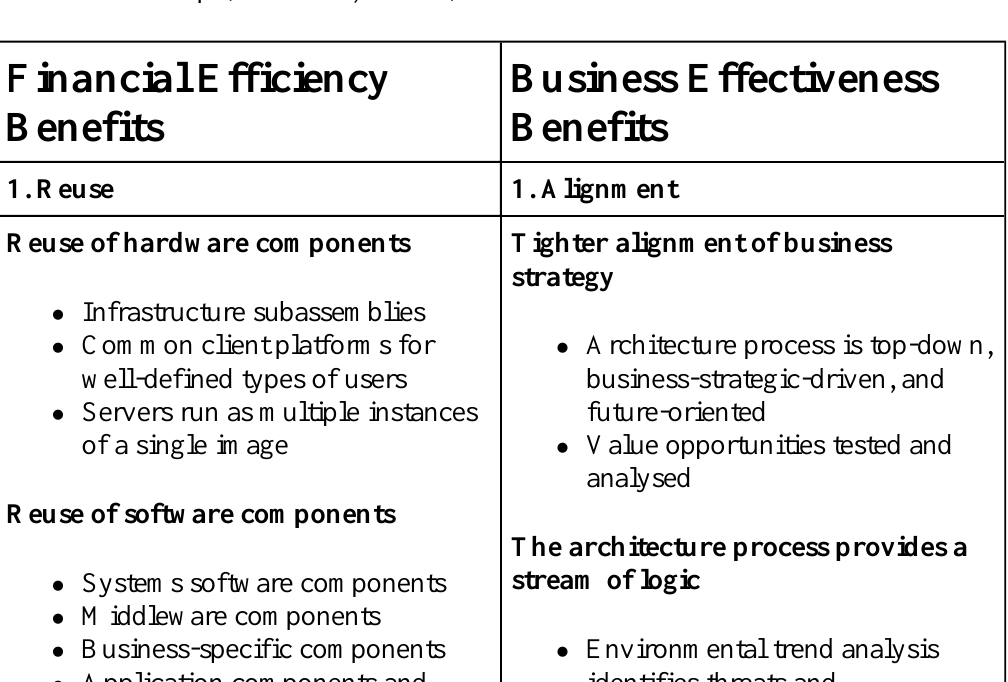
Table 1 META Group (Buchanan,